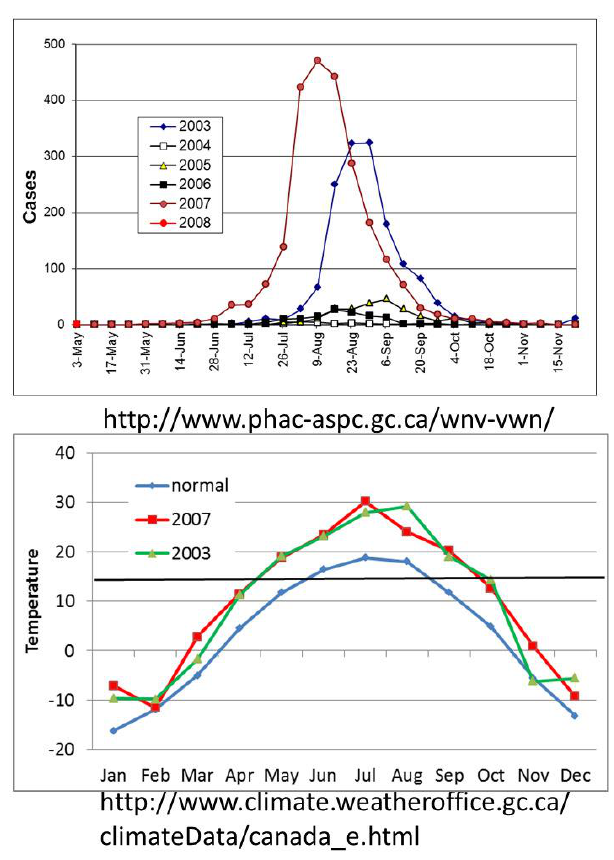
Figure 6. Number of human cases of WNV reported by the Canadian government per year, 2003–2008, and the mean monthly temperature in Regina Saskatchewan in °C for the 50 year average [1950–2000], 2003 and 2007. Horizontal line in bottom panel shows the 14.3 °C threshold for WNV